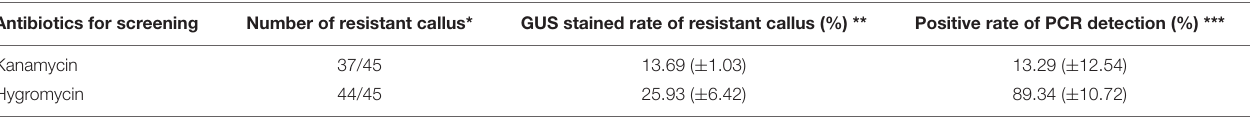
TABLE 2 | Effects of kanamycin and hygromycin on the transformation efficiency of L. olgensis. Antibiotics for